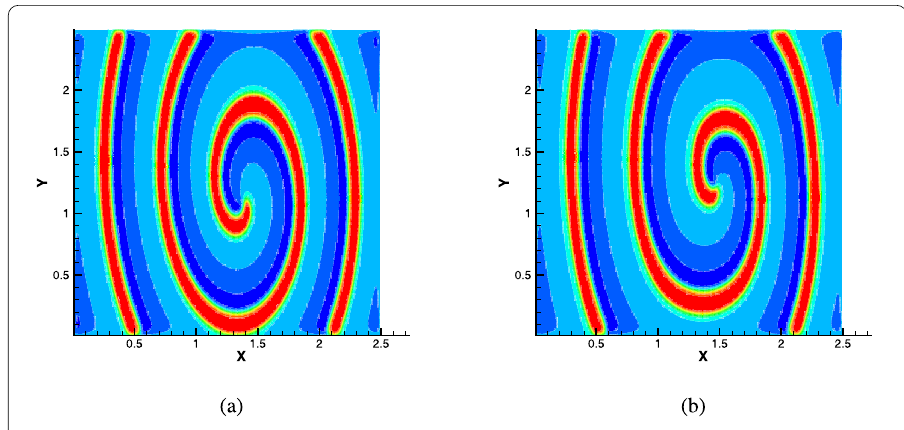
Figure 3 Solutions of Example 2 for varying diffusion coefficient and fractional power: ( a ) α x = α y = 2 and K x = 1 E – 4, K y = 2.5 E – 5, ( b ) α x = 2, α y = 1.7 and K x = K y = 1 E –